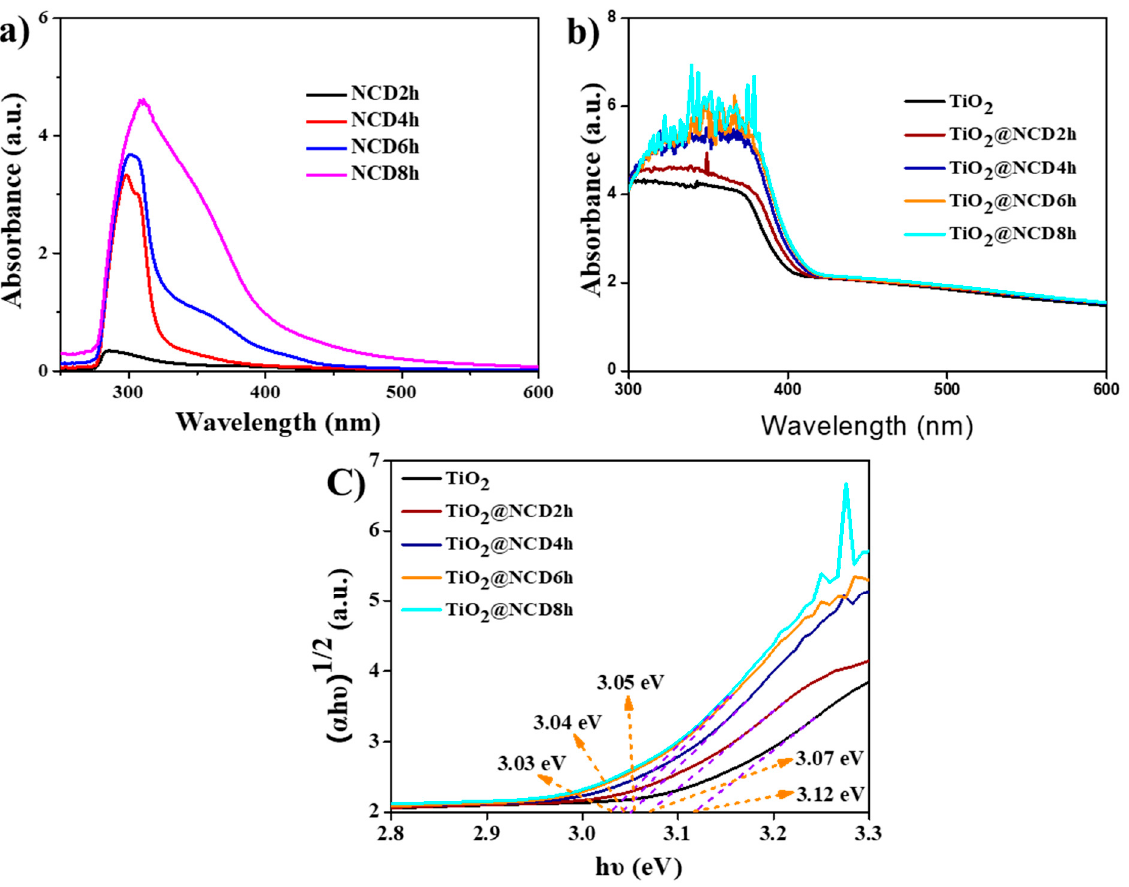
Figure 6. Absorption spectrum of ( a ) NCDs solutions. ( b ) Pristine TiO 2 and TiO 2 @NCDs thin films ( c )bandgap energy of Pristine TiO 2 and TiO 2 @NCDs thin films.